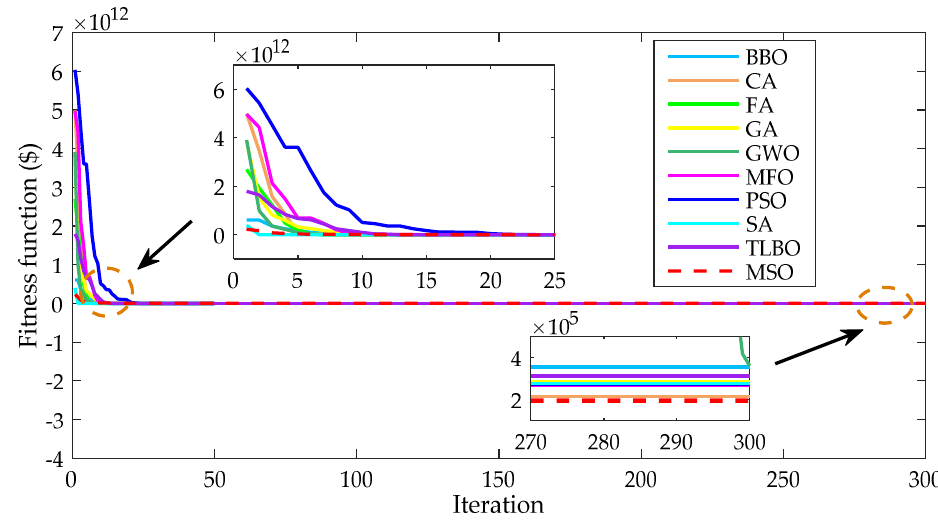
Figure 10. Convergence process of a total operating costs obtained by different algorithms. Table 6. Comparative results of optimal solutions obtained by different algorithms.